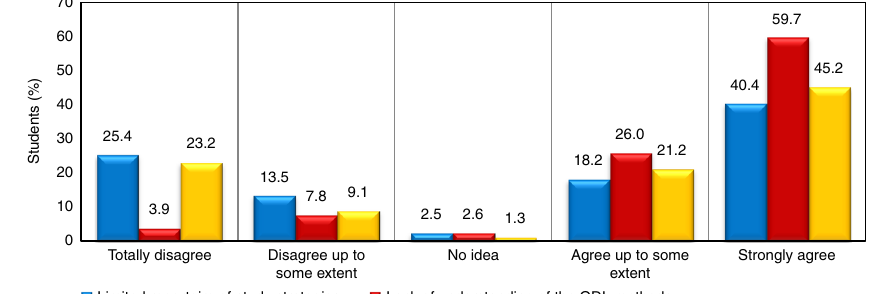
Figure 6. Psychological barriers rated as significant for on- time completion of the degree